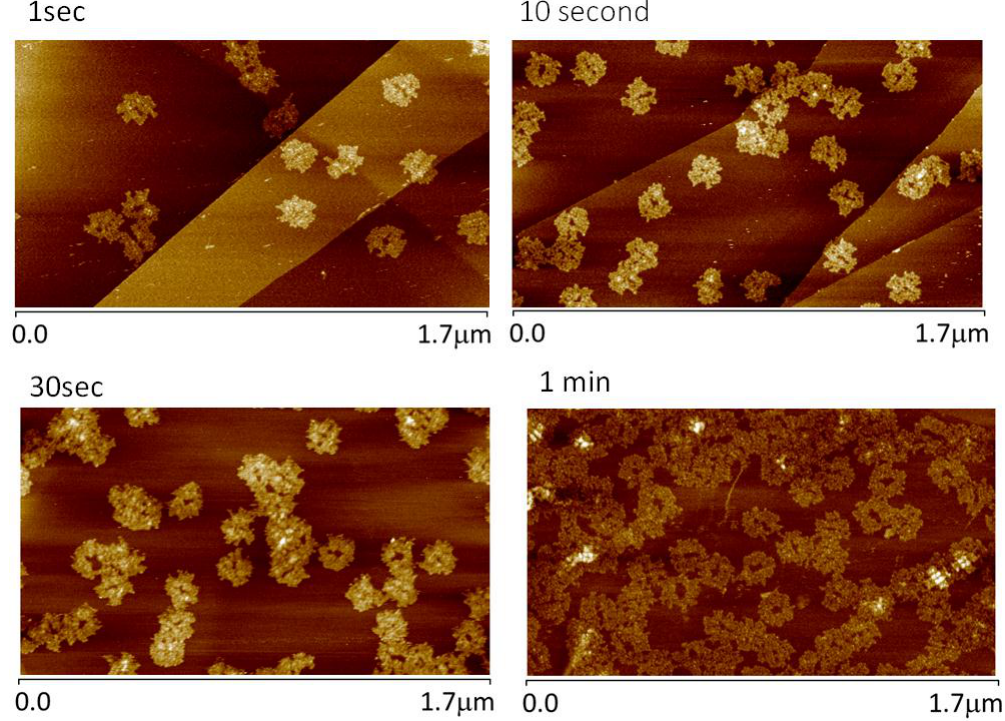
Figure 6. AFM images of different HOPG surfaces exposed to purified, 0.3 nM cDO E solution for periods ranging from 1 s to 1 min.